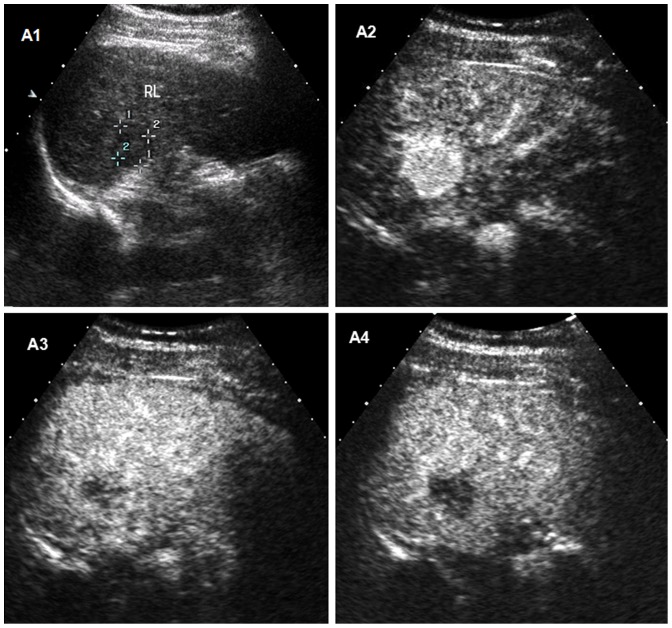
Intrahepatic cholangiocellular carcinoma (ICC) in a 48-year old man with cirrhosis.A1 Conventional ultrasound shows a hypoechoic nodule of 22-enhanced ultrasound, the lesion appears as homogeneous hyperenhancement 19 seconds after the administration of contrast agent. A3 The lesion shows first wash-out 38 seconds after the injection of contrast agent. A4 The lesion appears as marked wash-out at 50 seconds after the administration of contrast agent.